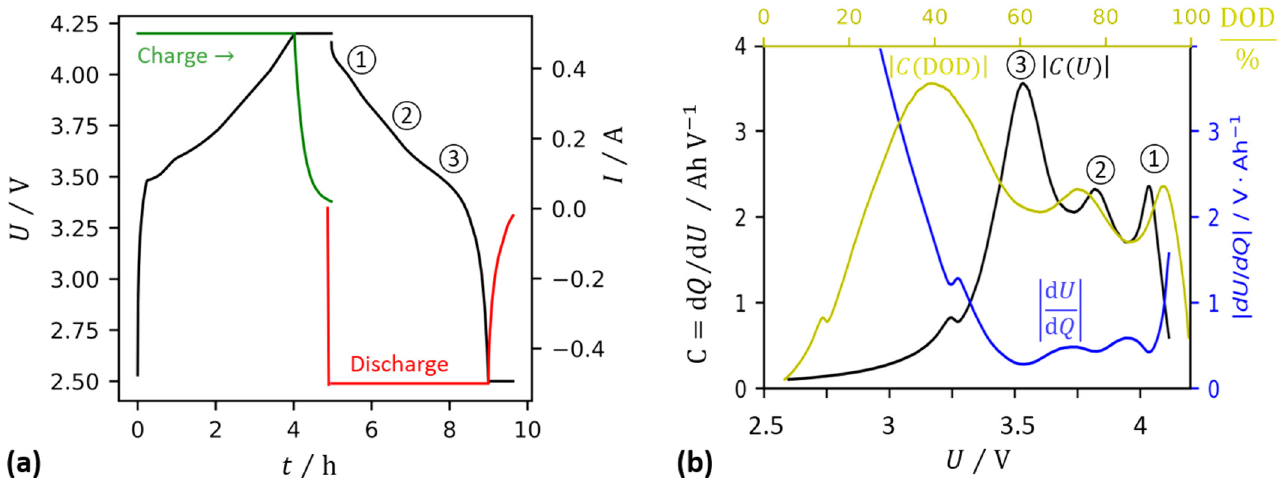
Figure 4. Used lithium-ion battery (Panasonic NCR18500A). ( a ) Constant current charge–discharge characteristics: U cell voltage, I current. ( b ) Discharge: differential capacity d Q /d U against cell voltage and depth-of-discharge and its reciprocal d U/ d Q . Sections ①②③ correspond to each other.